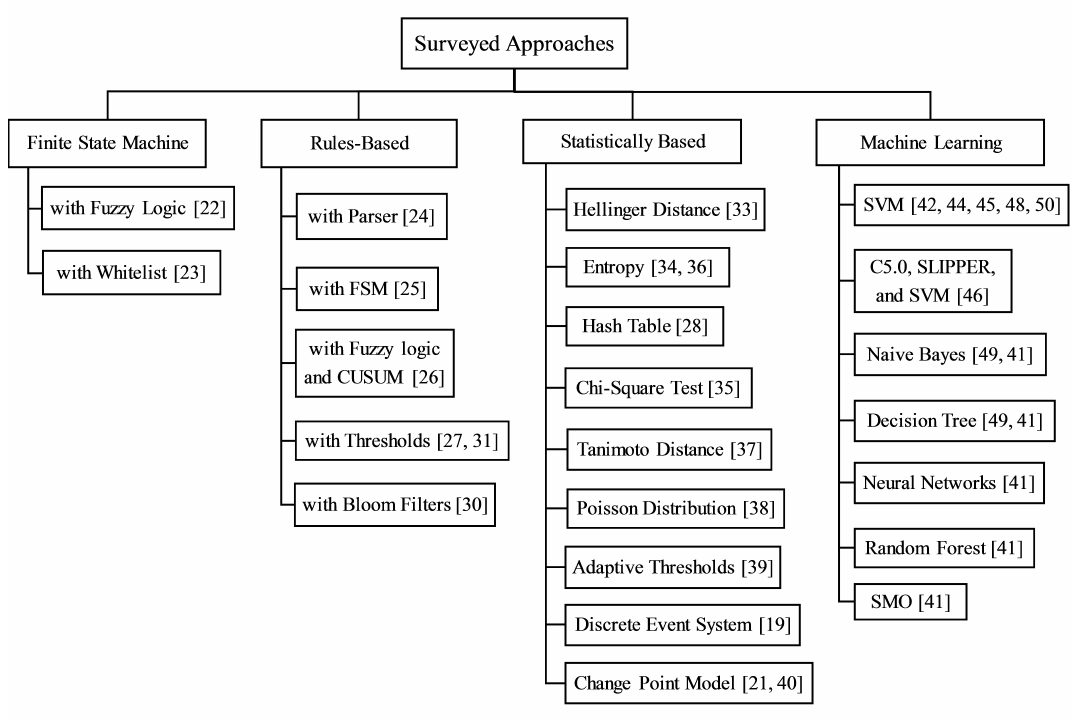
Figure 5. Classification of surveyed